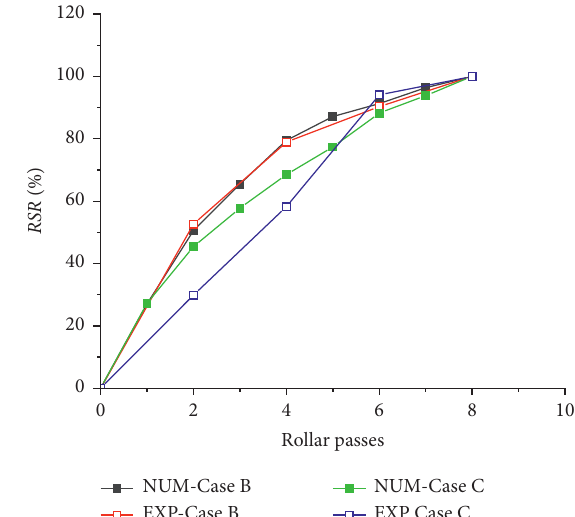
Figure 19: RSRs of the rockfill pavements in case B and case